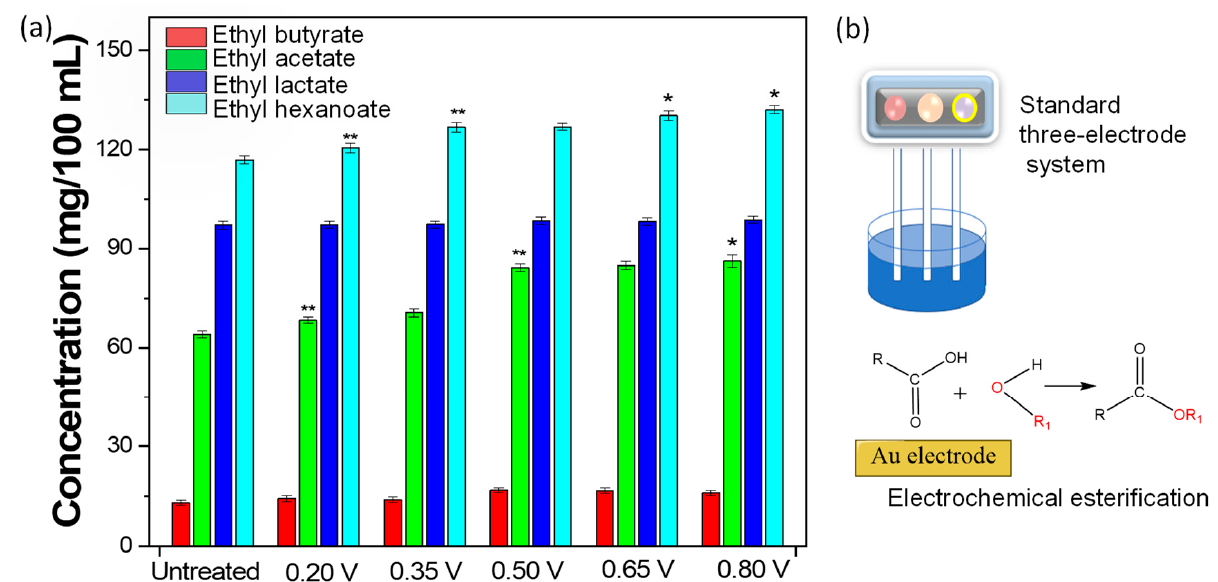
Figure 1. ( a ) The content of ethyl butyrate, ethyl acetate, ethyl lactate, and ethyl hexanoate in the electrochemically treated low-alcohol Baijiu (operating voltages: 0.2 V, 0.35 V, 0.5 V, 0.65 V, and 0.8 V), ethanol concentration in the Baijiu: 40% in volume ratio. (* p < 0.05 and ** p < 0.01, compared with the control) ( b ) Schematic representation of electrochemical esterification technology.